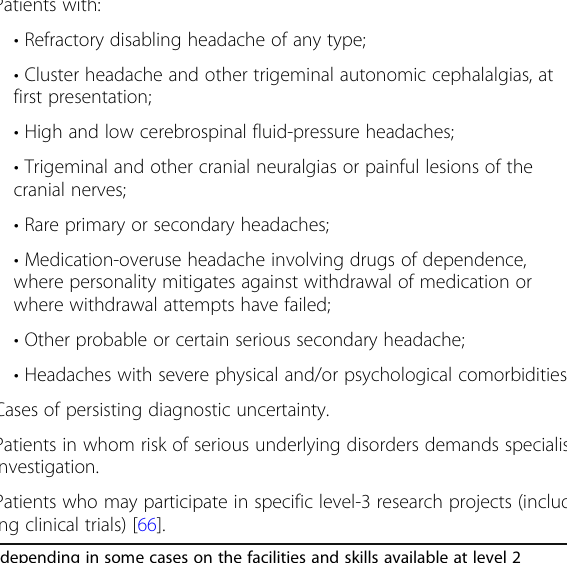
Table 5 Patients likely to be referred to level 3 within optimally structured headache services a (adapted from [29]) Patients